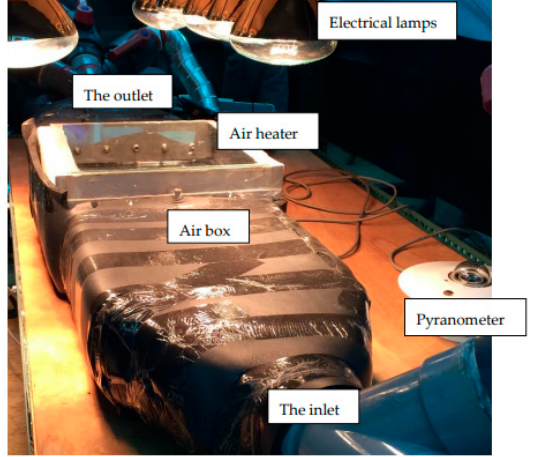
Figure 11. A photo of the external-recycle experimental setup.